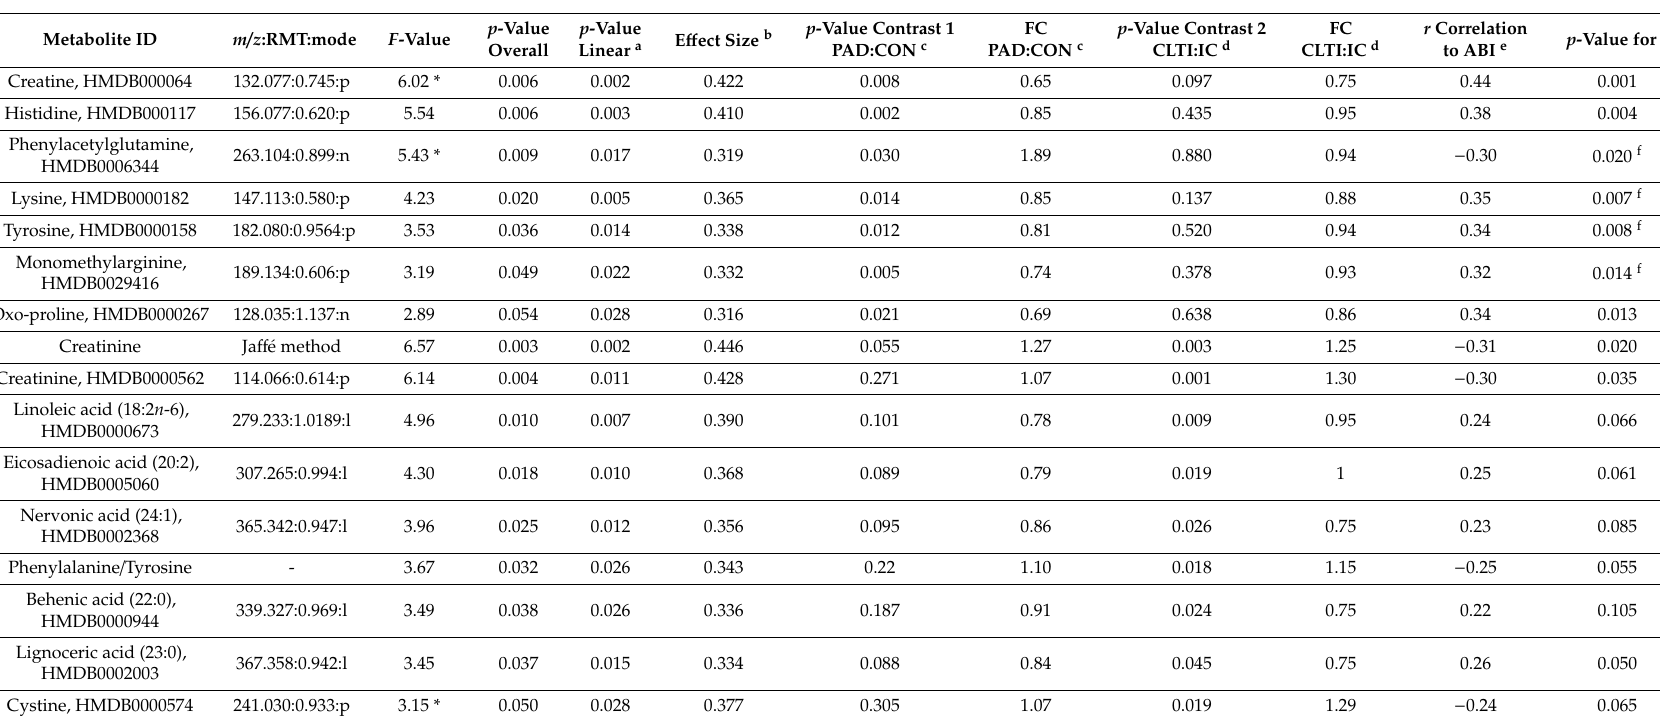
Table 2. Top-ranked serum metabolites showing significant changes reflecting disease progression when comparing PAD cases to non-PAD controls, as well as IC to CLTI patient sub-groups when using a one-way ANOVA with planned contrasts, including their correlation to the